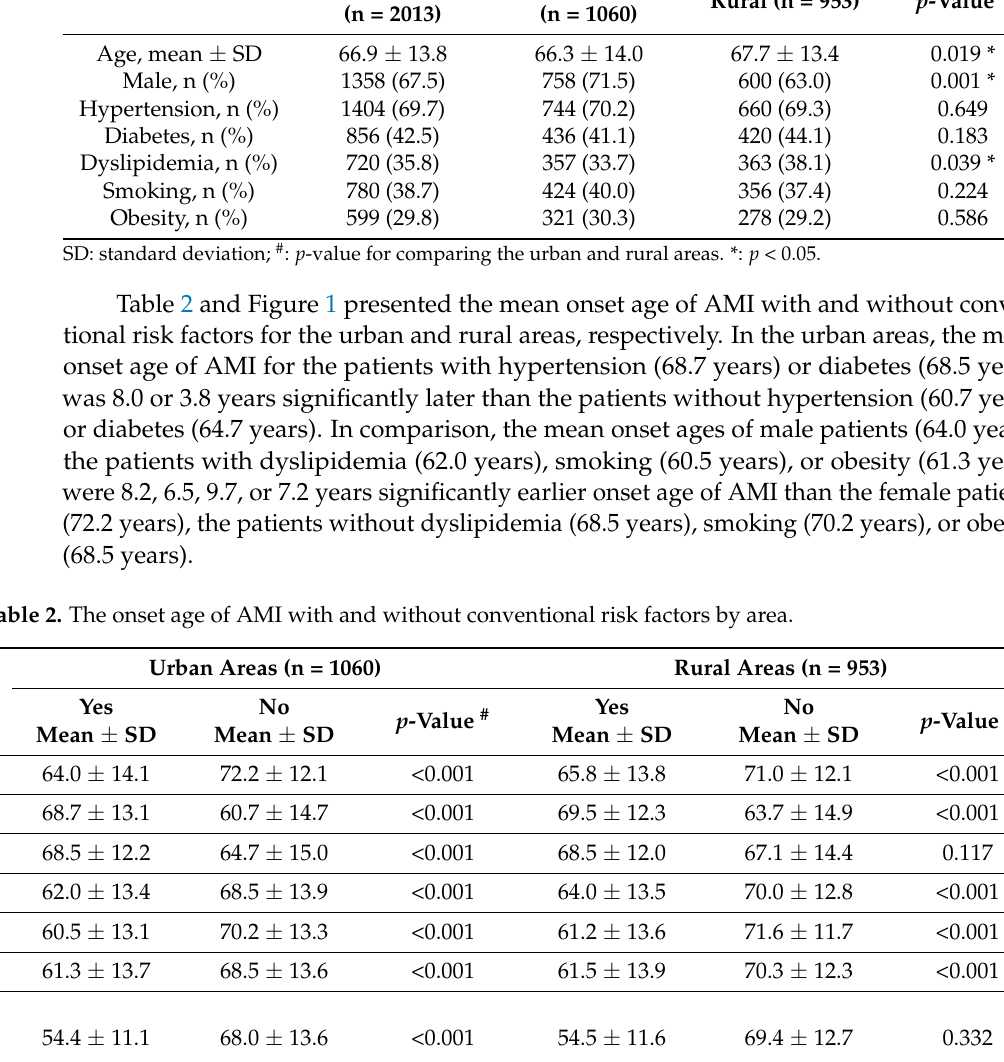
All Urban (n = 2013)